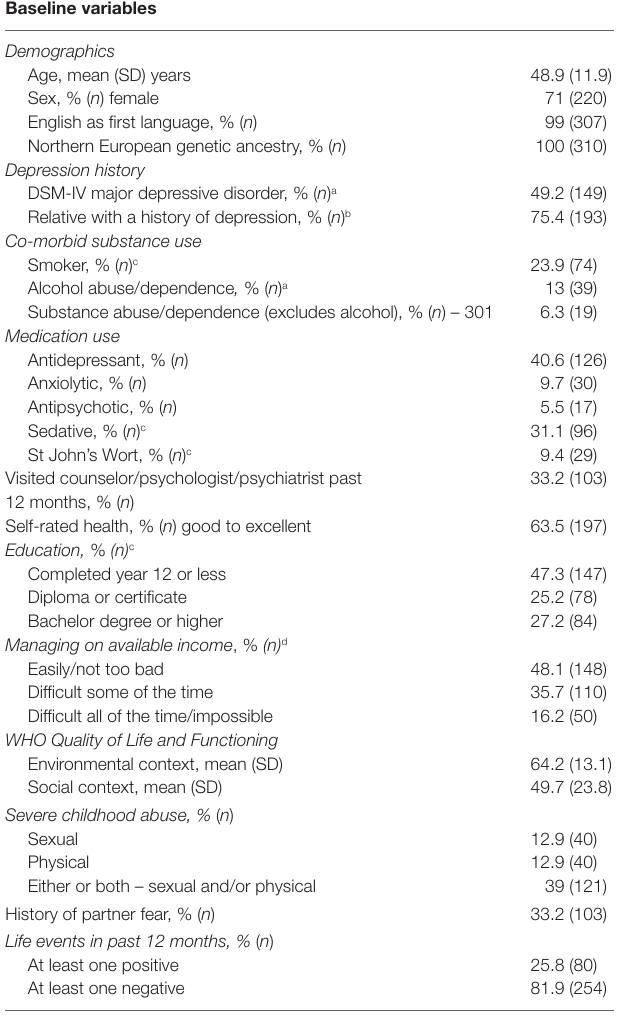
TaBle 1 | Participant characteristics ( n =